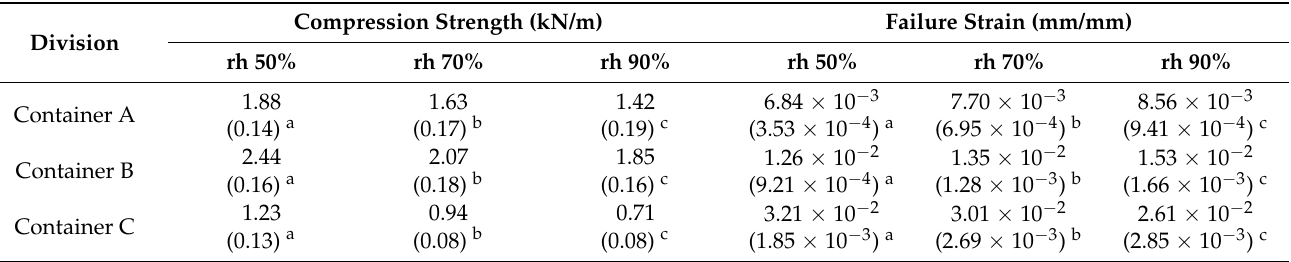
Figure 3. Stress–strain curves for the target shipping containers. Table 4. Compressive properties of the target shipping container according to the equilibrium condition [14].